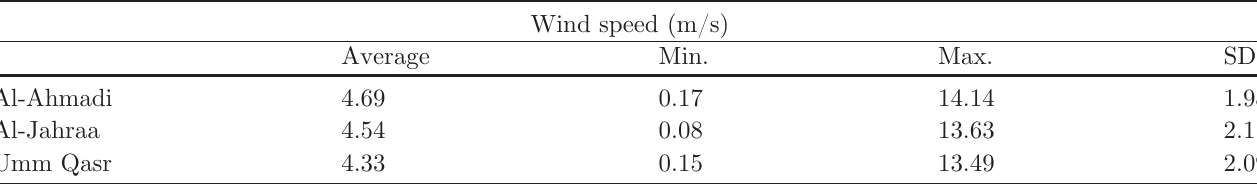
Table 2. Selected locations wind speed comparison.